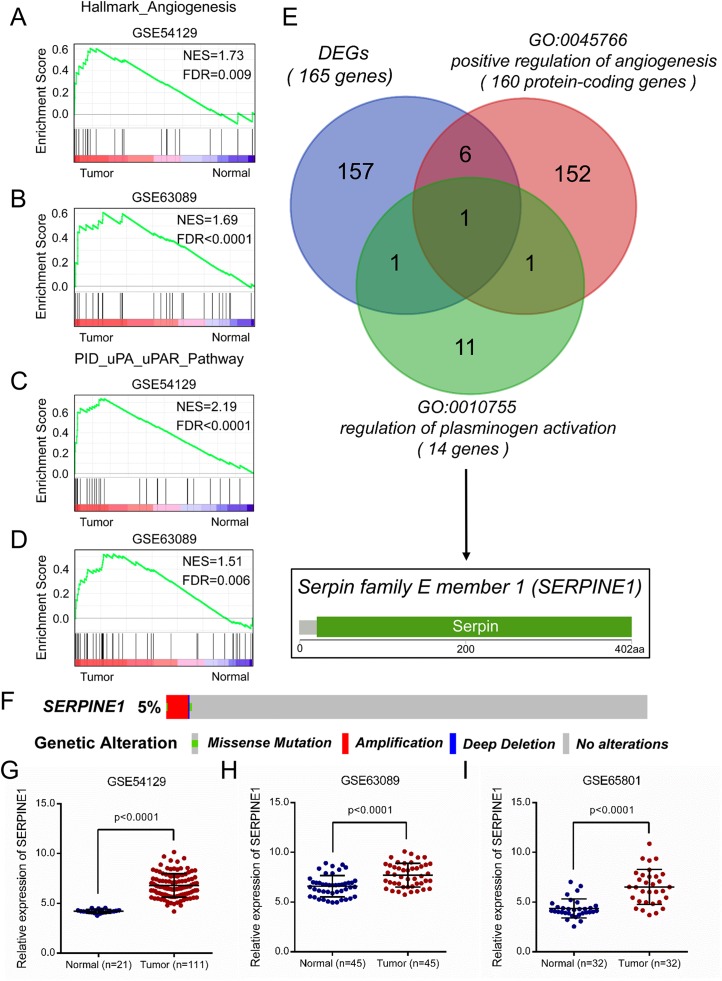
Overexpression of SERPINE1 in gastric cancer is identified by integrative approach.The GSEA analysis between normal gastric mucosa and gastric cancer tissues using the hallmark gene set of angiogenesis in (A) GSE54129 and (B) GSE63089 datasets. The GSEA analysis between normal gastric mucosa and gastric cancer tissues using gene set of uPA pathway in (C) GSE54129 and (D) GSE63089 datasets. NES, normalized enrichment score. FDR, false discovery rate. (E) The venn graph of DEGs and GO terms (positive regulation of angiogenesis and regulation of plasminogen activation). (F) The genetic alterations (mutation and copy number) of SERPINE1 in TCGA STAD dataset. STAD, stomach adenocarcinoma. The relative mRNA level of SERPINE1 in normal and gastric cancer tissues of the (G) GSE54129, (H) GSE63089, and (I) GSE65801 datasets were analyzed using the independent sample t-test, respectively.